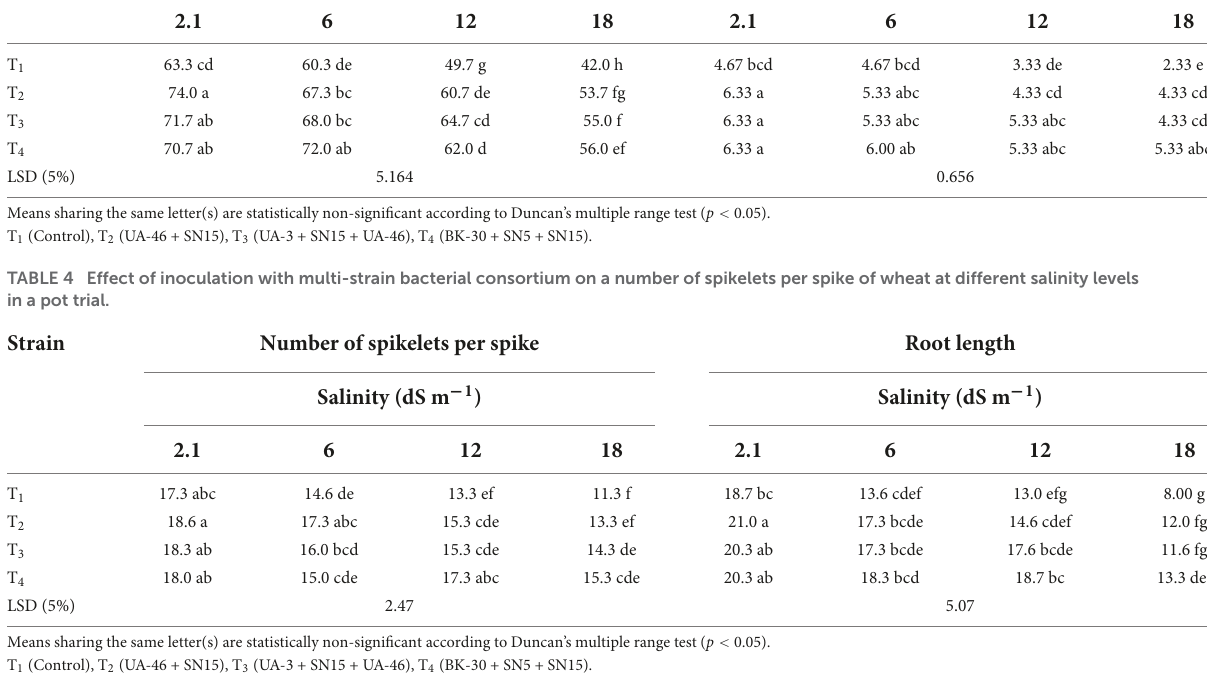
TABLE 5 Effect of inoculation with multi-strain bacterial consortium on grain yield (g pot − 1 ) and 1,000-grain weight of wheat at different salinity levels in a pot trial.